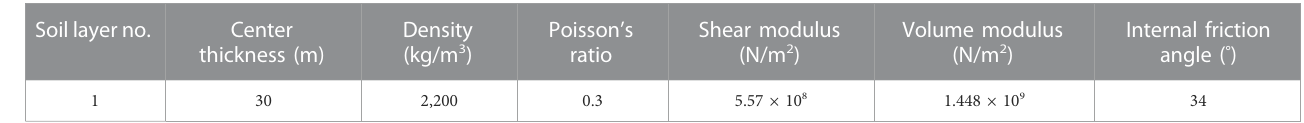
TABLE 1 Parameters of the soil foundation layer.